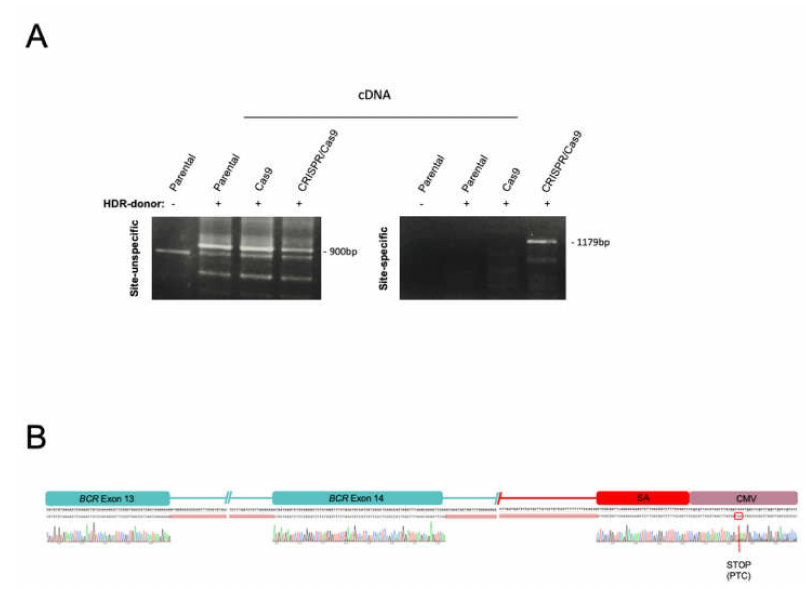
Figure 3. Expression analysis of target locus. ( A ) RT-PCR of BCR/Venus fusion RNA (900 bp site- unspecific, oligos: In5 (cid:48) F/VenusR; 1179 bp site-specific, oligos: BCRqPCRF/VenusR), in cells electro- porated with the CRISPR-Trap system (CRISPR-Cas9 + HDR donor) and controls (Parental, Parental + donor, Cas9 + donor). ( B ) Sanger sequencing of site-specific RT-PCR corresponding to a BCR/Venus of K562 electroporated cells with the CRISPR-Trap system.